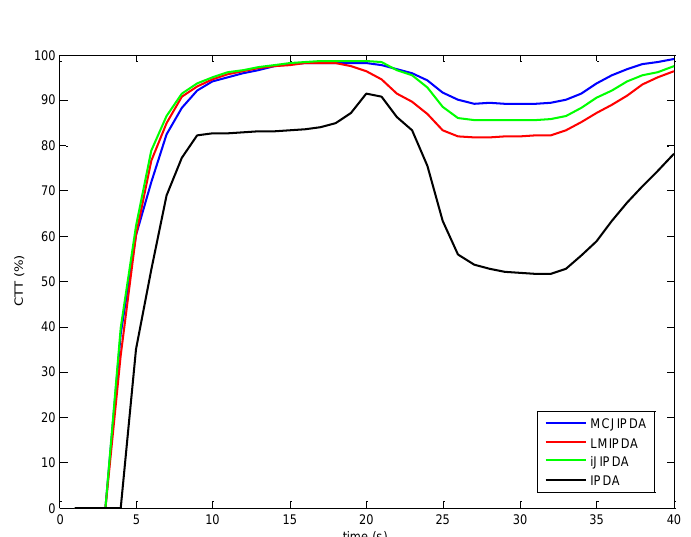
Figure 8. The confirmed true tracks rate for Case #3.